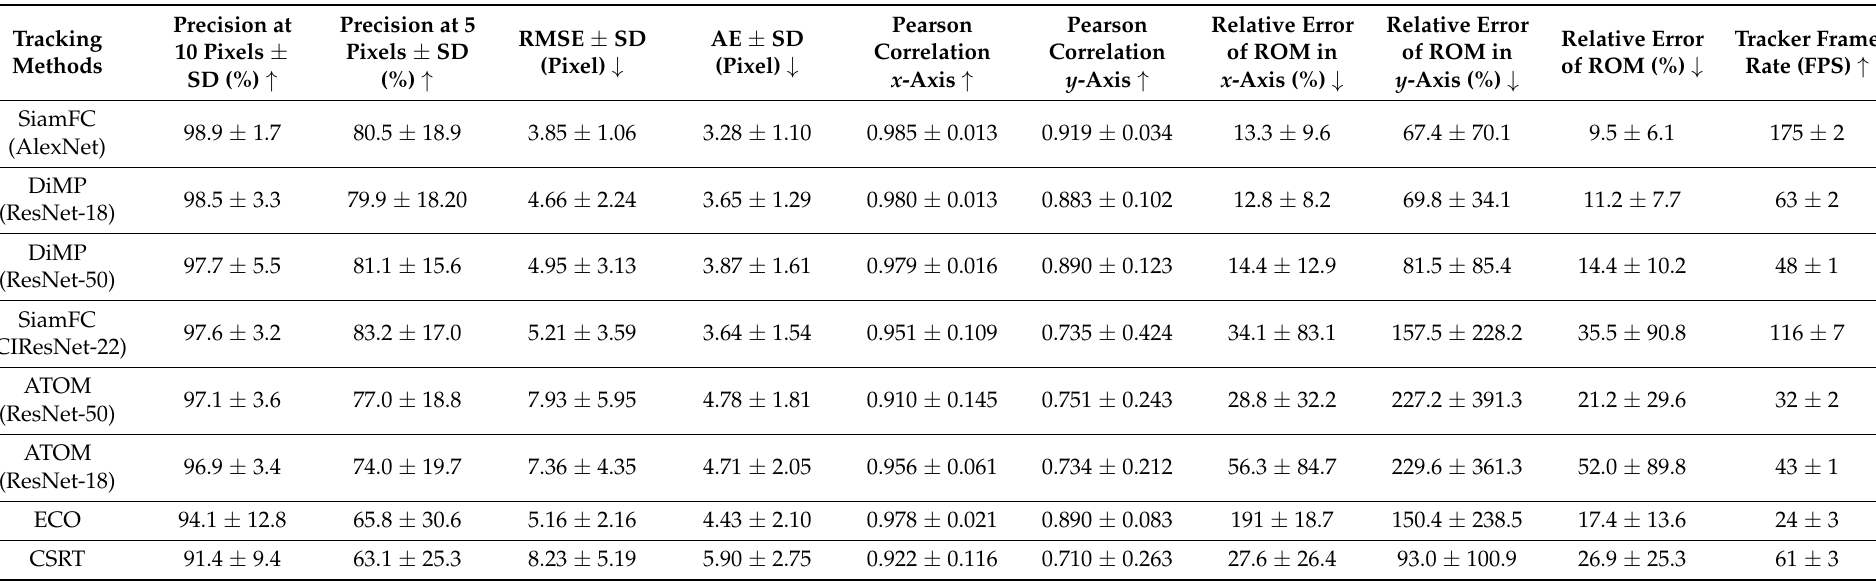
↑ ↓ : Arrow pointing up indicates larger value is preferred and arrow pointing down indicates smaller value is